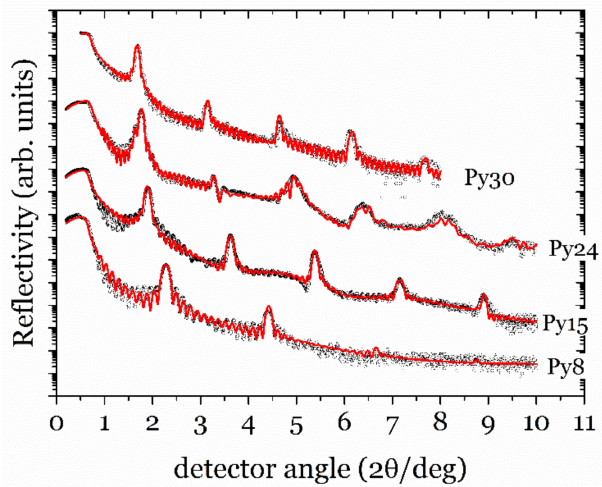
Figure 1. Experimental X-ray reflectivity data (open circles) and simulations (line) for all the